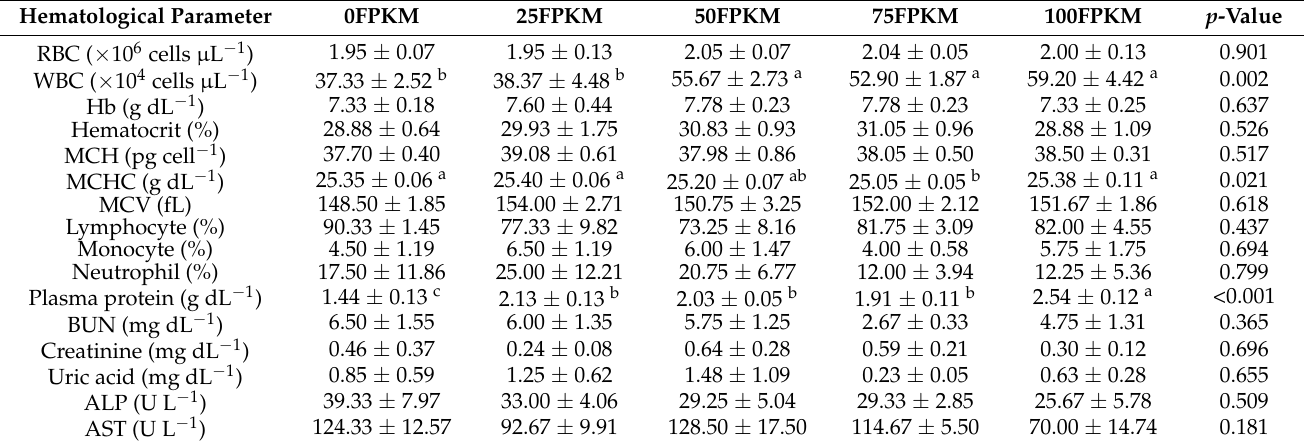
Table 7. Hematological parameters of sex-reversed red tilapia fed with experimental diets containing varying levels of FPKM for 12